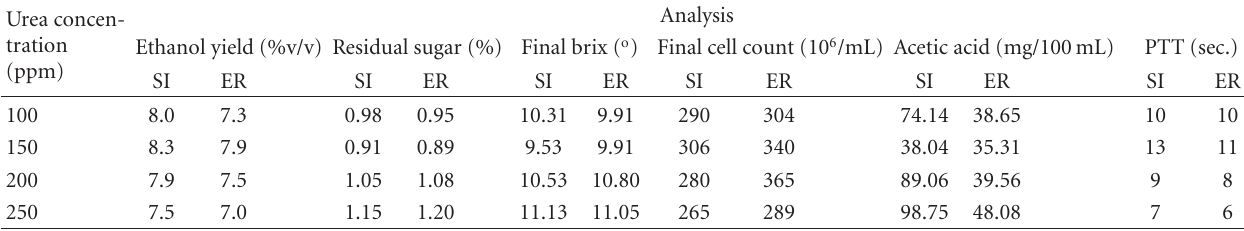
∗ SI: Saf-Instant and ER: Ethanol